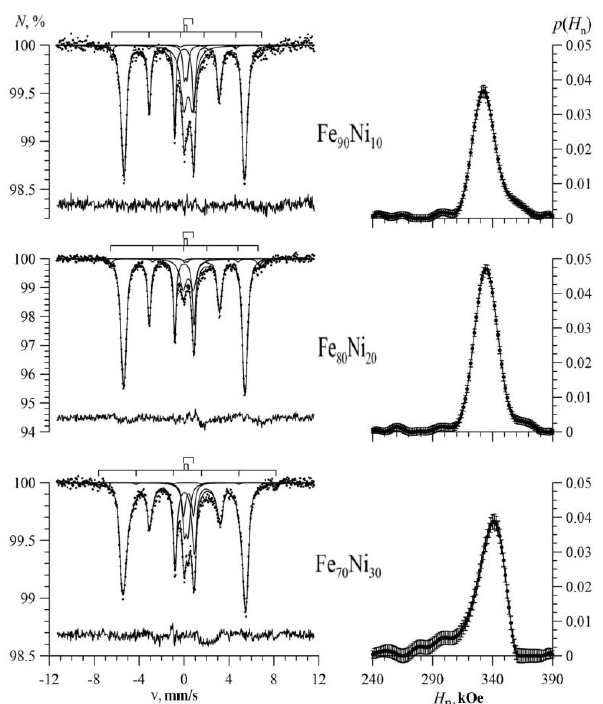
Figure 4. Mössbauer spectra (left) and the result of reconstructing the distribution of the hyperfine magnetic field (right) of Fe 100-x Ni x nanotubes at x = 10%; 20%; 30%.